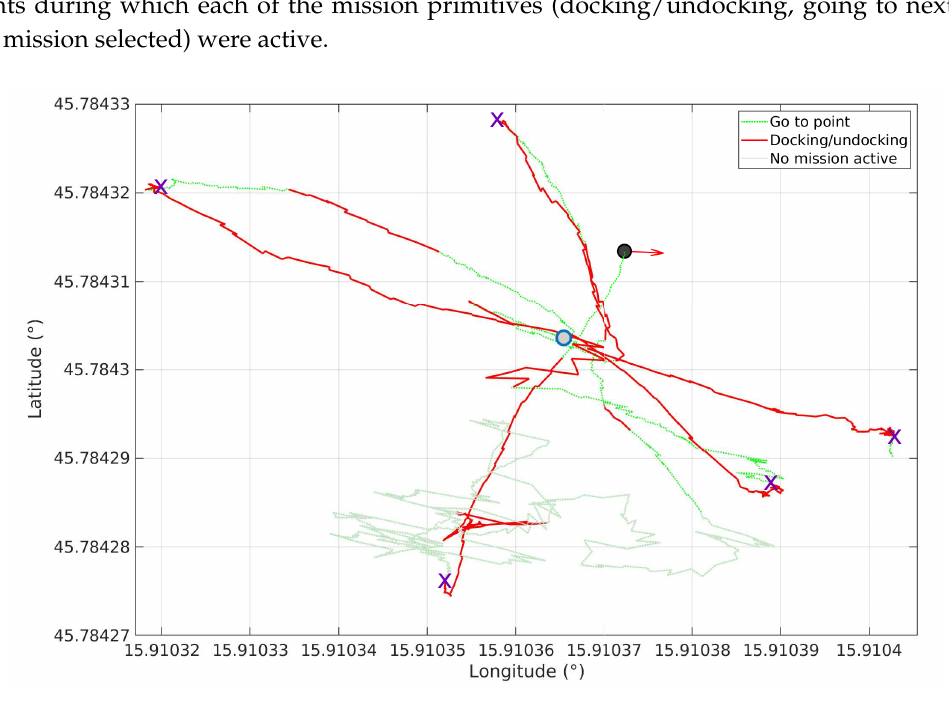
Figure 19. Structured docking experiment full mission trajectory. The blue circle marker represents the position of the anchored aMussel. The aPad is represented by a black circular marker and its heading denoted by a red arrow. Starting positions marked with